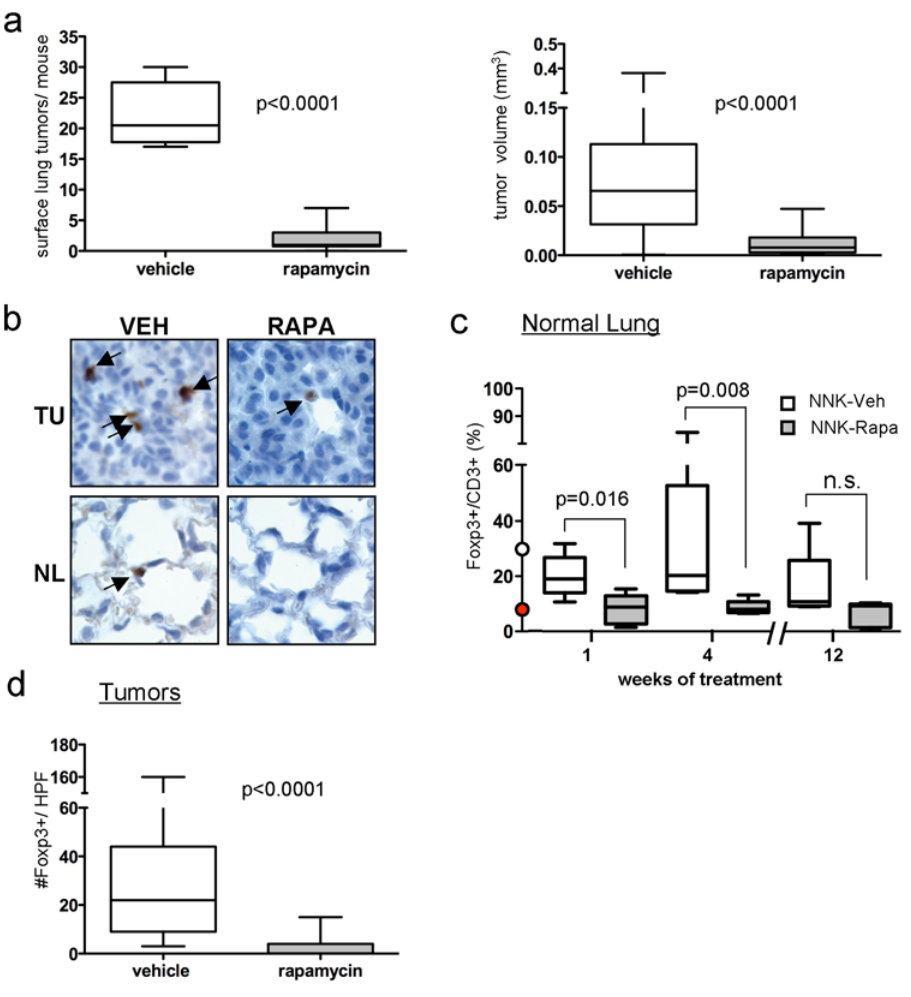
Figure 2. Rapamycin prevents NNK-induced tumorigenesis and depletes lung-associated Foxp3 + cells in NNK-treated mice. ( a ) Tumor multiplicity (left) and tumor size (right) after 12 wk of rapamycin or vehicle. ( b ) Representative staining for Foxp3 + cells in tumors (TU) and normal airway epithelium (NL). ( c ) The fraction of Foxp3 + /total CD3 + cells in normal lung tissues from saline or NNK-exposed mice treated with rapamycin or vehicle for 1, 4 or 12 weeks was calculated after IHC was performed. The red and white dots at week 0 indicate the percentages of Foxp3 + /CD3 + cells in the lungs of A/J mice prior to and after NNK administration, respectively. ( d ) The number of Foxp3 + cells in tumors arising 16 weeks after NNK exposure in the presence or absence of rapamycin was determined using IHC. For (a, c, and d), boxes indicate interquartile range, lines indicate median, and whiskers indicate minimal and maximal values. A high-powered field (HPF) indicates a field under 100 6 magnification. doi:10.1371/journal.pone.0005061.g002 (Fig. 3c, left panel), decreased lung-associated Foxp3 + cells by 65% (Fig. 3c, right panel) and decreased the multiplicity of IO33 adenocarcinomas by 80% (Fig. 3d). These results are similar to the results observed with rapamycin in the studies using NNK.